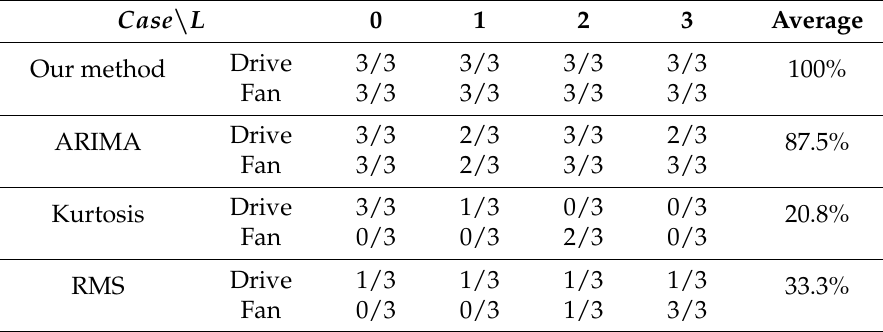
Table 2. Results of loading change for different setting initial working loads L